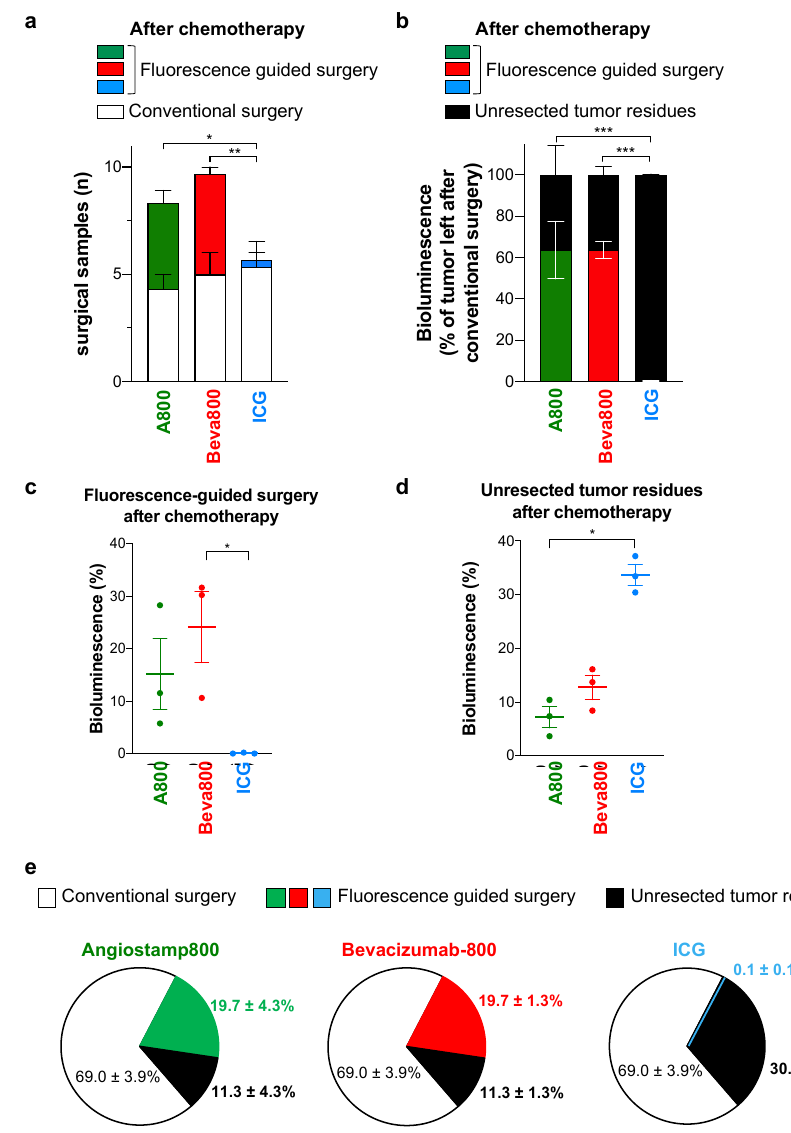
Figure 4. Angiostamp800 and Bevacizumab-IRDye 800CW, but not ICG, improved fluorescence-guided surgery for peritoneal carcinomatosis after chemotherapy. ( a ): Mean number of tumor nodules resected by conventional and fluorescence-guided surgery after neoadjuvant chemotherapy. * p = 0.01; ** p = 0.004; two-way ANOVA with Tukey post-hoc tests. ( b ): Bioluminescence of tumor resected by fluorescence-guided surgery and unresected tumor residues left in mouse body, expressed as a percentage of tumor left after conventional surgery in mice operated after neoadjuvant chemotherapy (mean ± SEM). *** p < 0.001; two-way ANOVA with Tukey post-hoc tests. ( c ): Bioluminescence signals of tumor nodules resected by fluorescence-guided surgery in mice operated after chemotherapy and expressed as the percentage of total tumor burden in mice. * p = 0.02; Kruskal–Wallis test with Dunn’s multiple comparison post-hoc tests. ( d ): Bioluminescence signals of unresected tumor residues after the 2-step surgery in mice after chemotherapy, and expressed as the percentage of total tumor burden in mice. * p = 0.01; Kruskal–Wallis test with Dunn’s multiple comparison post-hoc tests. ( c , d ): Each dot represents one mouse. Bars, mean ± SEM. ( e ): Pies show bioluminescence of tumor nodules resected by conventional and fluorescence-guided surgery and of unresected tumor residues (false-negative fluorescent signal) in mice operated on after chemotherapy and expressed as the percentage of total tumor burden (mean ±